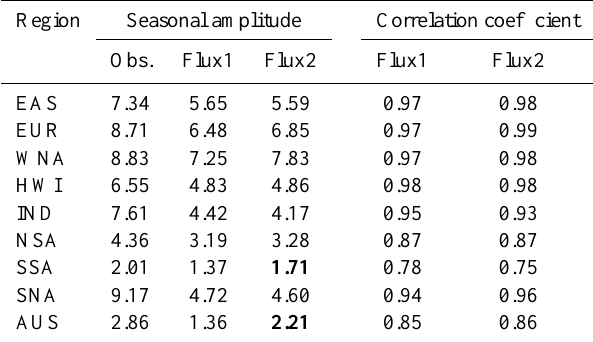
Table 5. Seasonal amplitudes of the observed and simulated con- centrations at 5–6km over each area for the period 2006–2007, and correlation coefficients between the observed and simulated sea- sonal cycles. The simulated amplitudes are averaged for the four models. Bold font in the Flux2 column represents a value signif- icantly different from Flux1 at 95% confidence level. The aver- age correlation coefficient is derived by back transforming the aver- aged Fisher z . All the correlations are significant at 95% confidence level. Region Seasonal amplitude